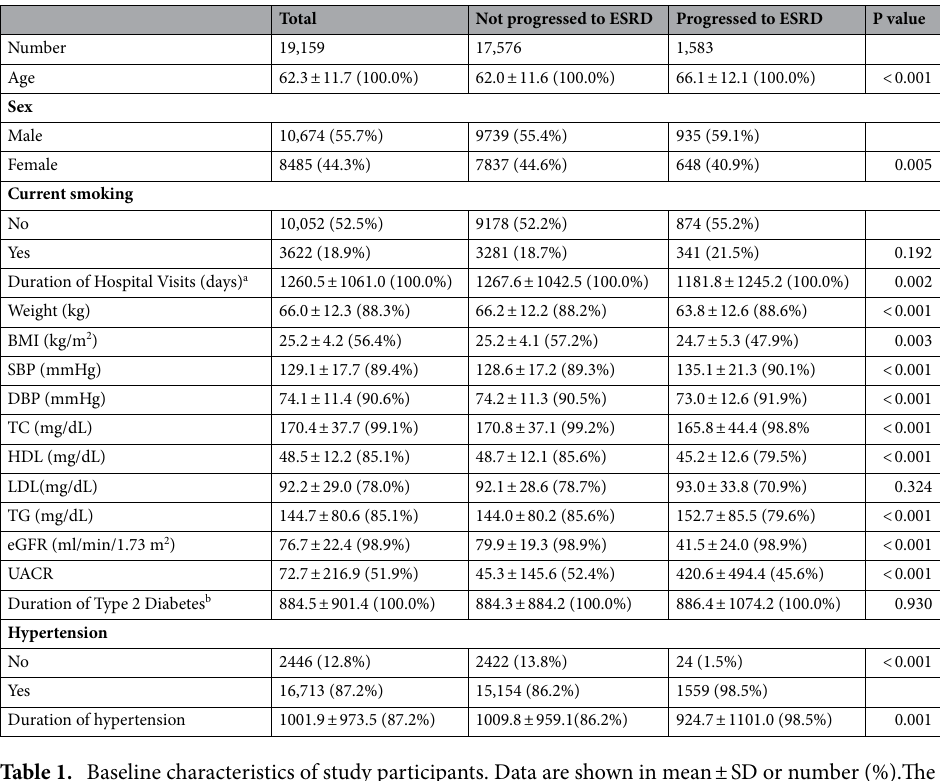
Table 1. Baseline characteristics of study participants. Data are shown in mean ± SD or number (%).The percentage in the parenthesis indicates the percentage of non-zero values (continuous variables) or the percentage of a given category (categorical variables). Patient characteristics are calculated from one randomly selected cohort. ESRD end stage renal disease, BMI body mass index, SBP systolic blood pressure, DBP